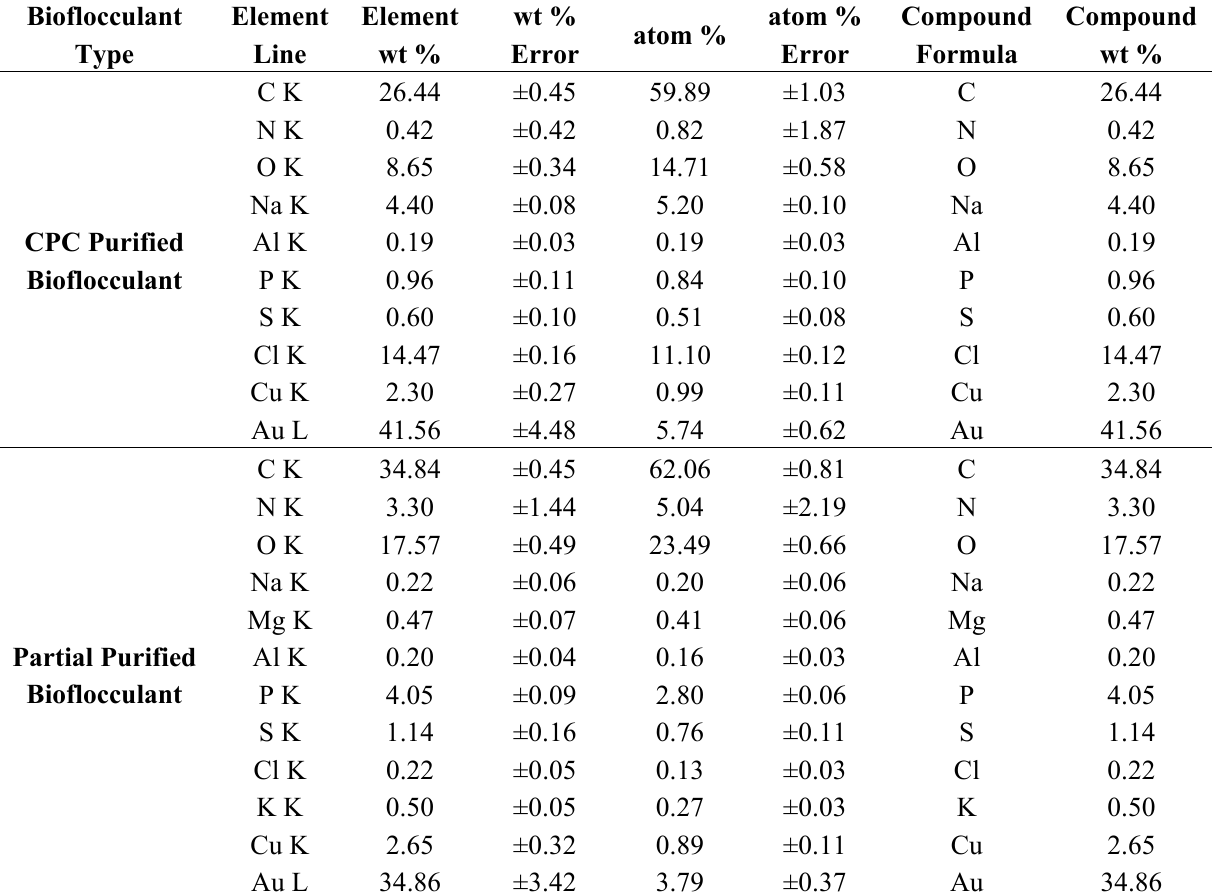
Table 3. Elemental composition of purified bioflocculant produced by Brachybacterium sp. (UFH)